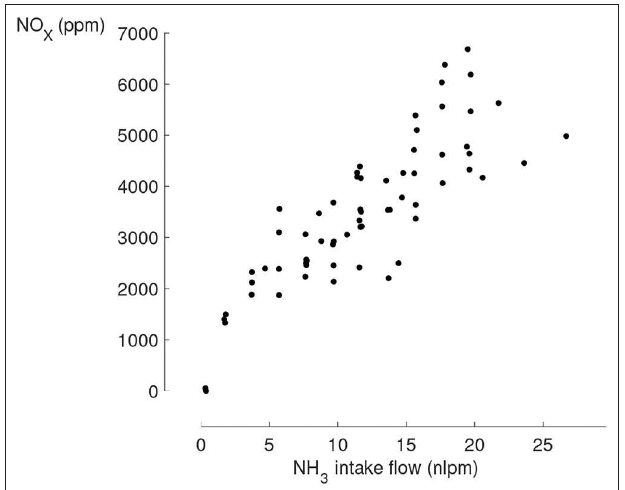
FIGURE 18 | NO X emissions as a function of the ammonia intake flow (all the experiments, CA50 = 4 ± 2 CAD, T max > 1,400 K). As soon as ammonia is blended with hydrogen NO X emissions appear above 1,000 ppm, and keep increasing with the ammonia fuel flow, here expressed in normal liters per minute (nlpm).